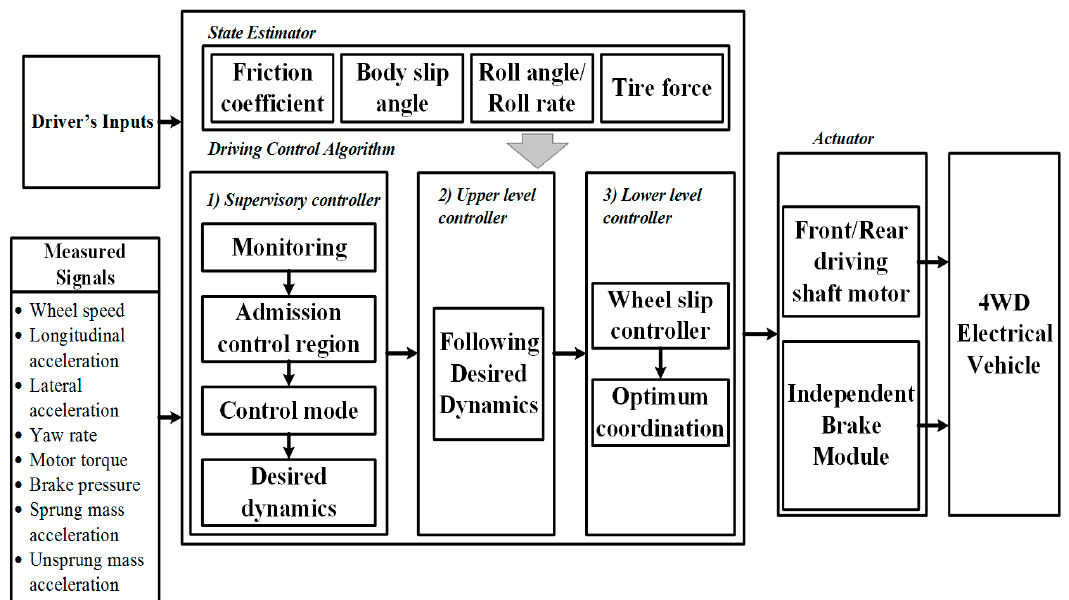
Figure 67. Working principle of the control system proposed by Kang et al. The system uses both the driver’s commands and sensor measurements as inputs, and then drives the actuators as determined by the three level control algorithms. Adapted from [177].